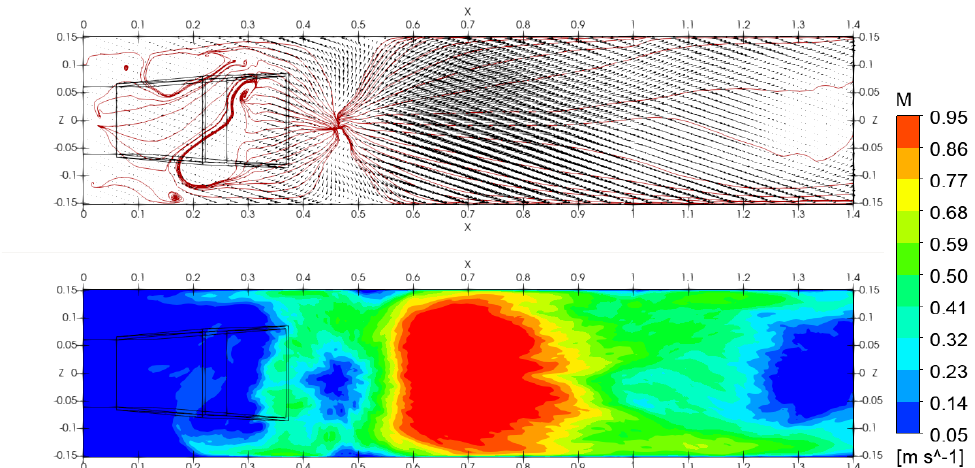
Figure 22. LBM, vector lines ( top ) and the magnitude of time-averaged 2D velocity ( bottom ) in horizontal plane ( y = 10mm ) .